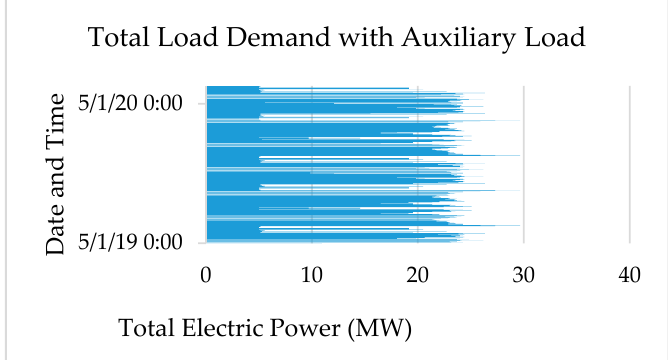
Figure A2. Ship Power Requirement (Yearly).